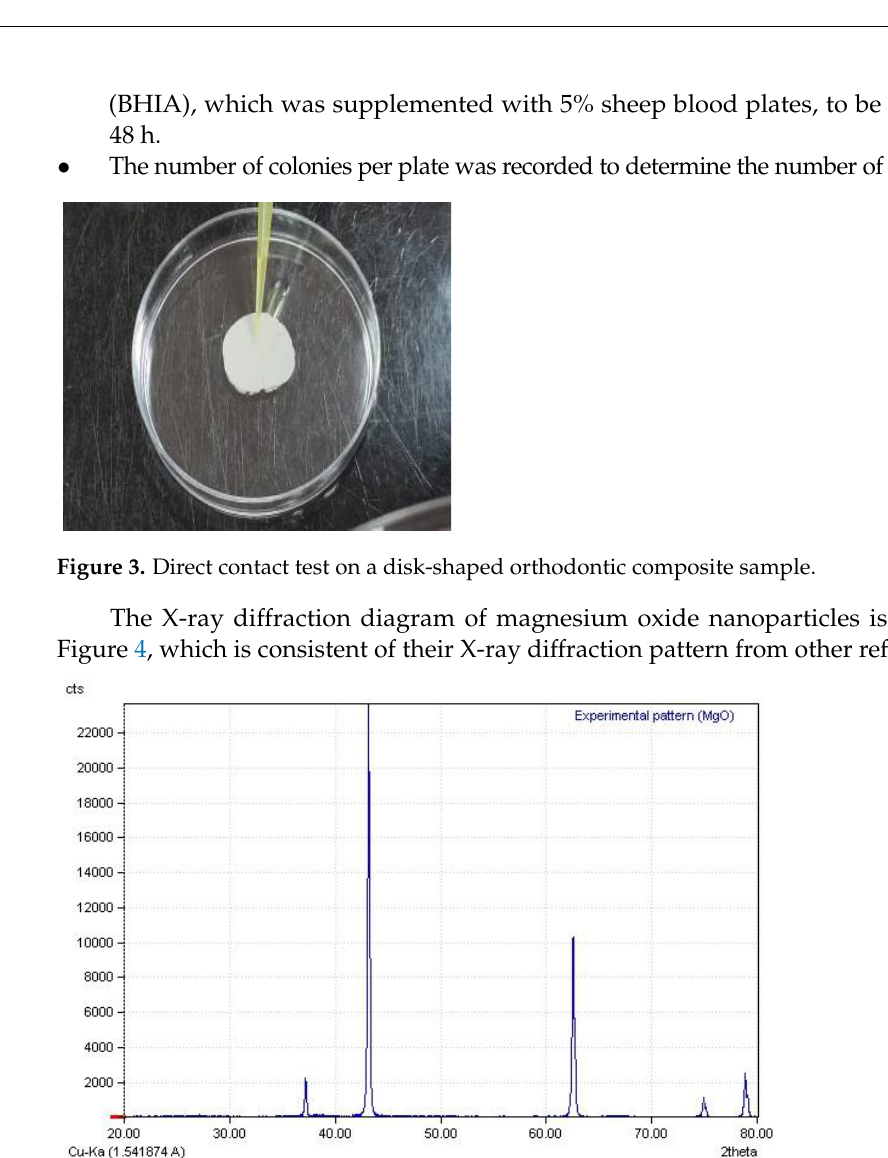
Table 1. Mean and standard deviation of the SBS in five different groups.